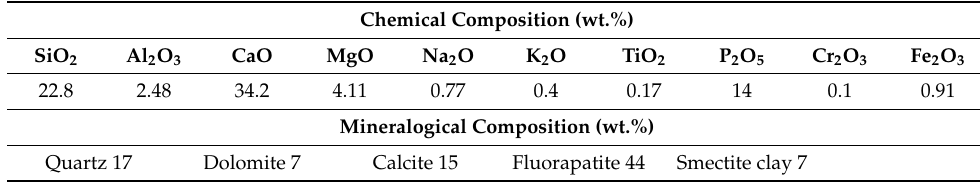
Table 1. Chemical and mineralogical composition of phosphate waste clay